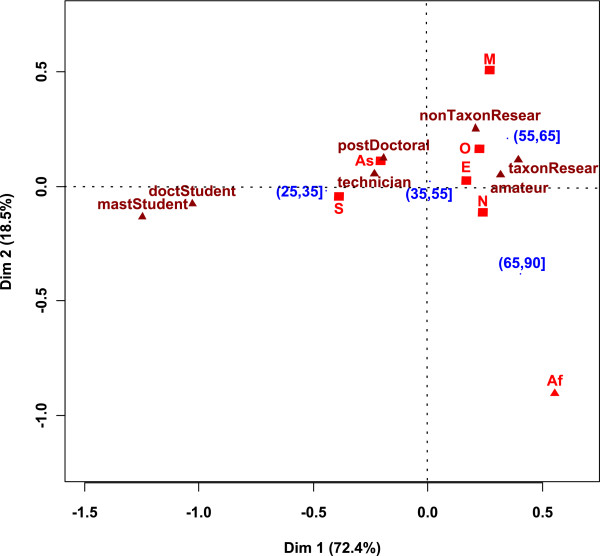
Result of the CA between the authors' nationality and age. Af: Africa, As: Asia, E: Europe, M: Middle East, O: Oceania, N: North America, S: South America. Professional status is used as supplementary data.